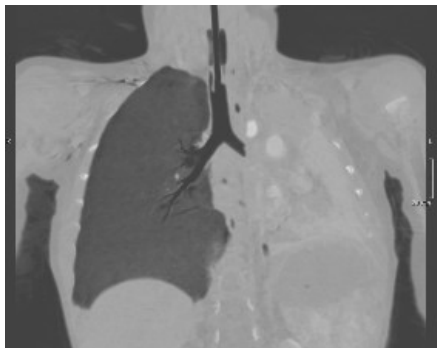
Figure 1. Left lung ultrasound showing a consolidation of the lung and the absence of the normal A lines.